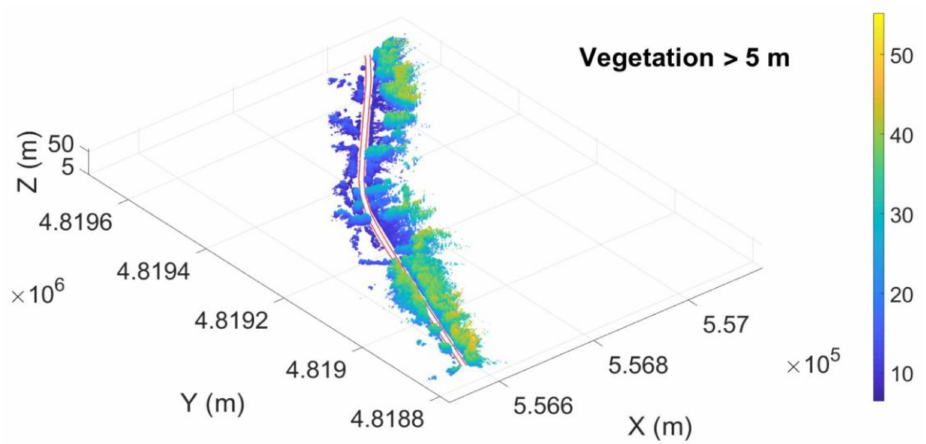
Figure 2. Vegetation points along roads in categories according to height (at a distance of more than 5 m from the road)